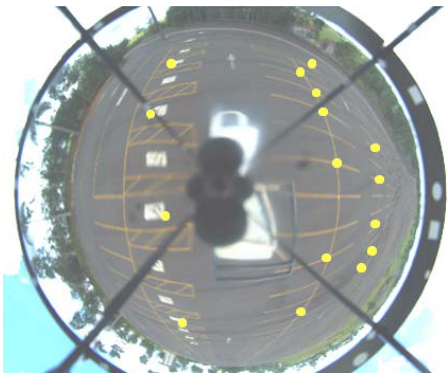
Figure 5: Omnidirectional image of the test area with GCP highlighted.